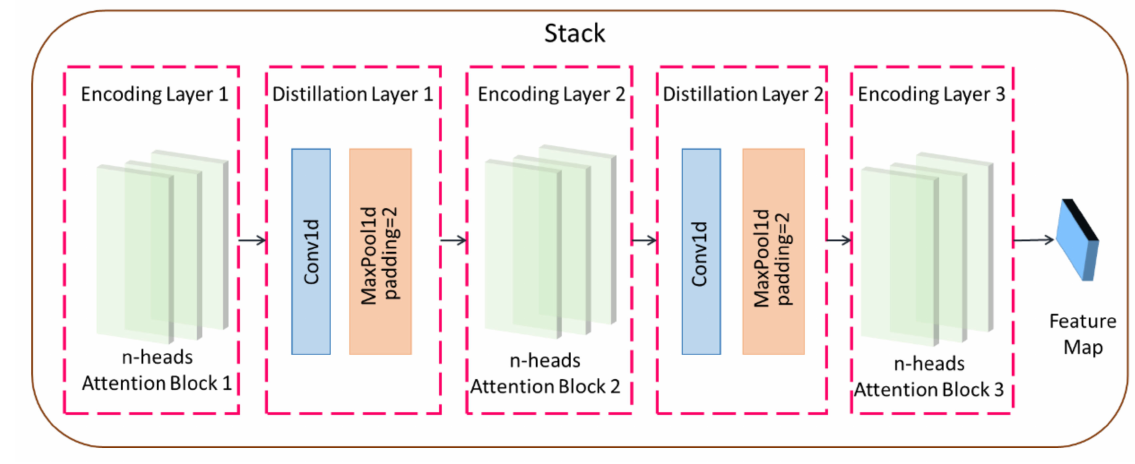
Figure 3. Stack structure